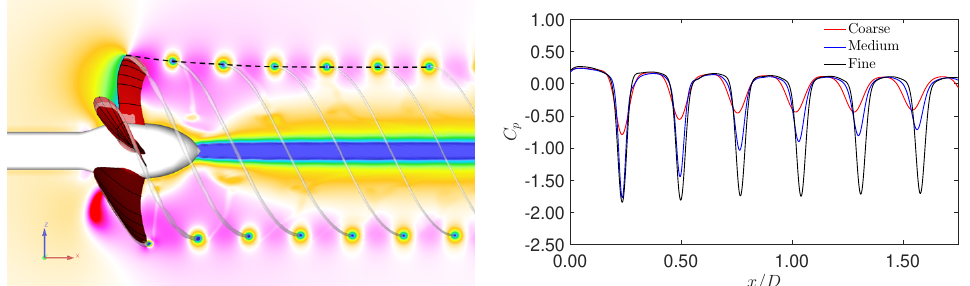
Figure 14. Pressure coefficient in the track of the tip vortex with different grid densities for the PPTC Case 1 conditions. Model-scale SST simulations. The figure on the left shows the fine grid SST simulations and the track as dashed line along which the C p is